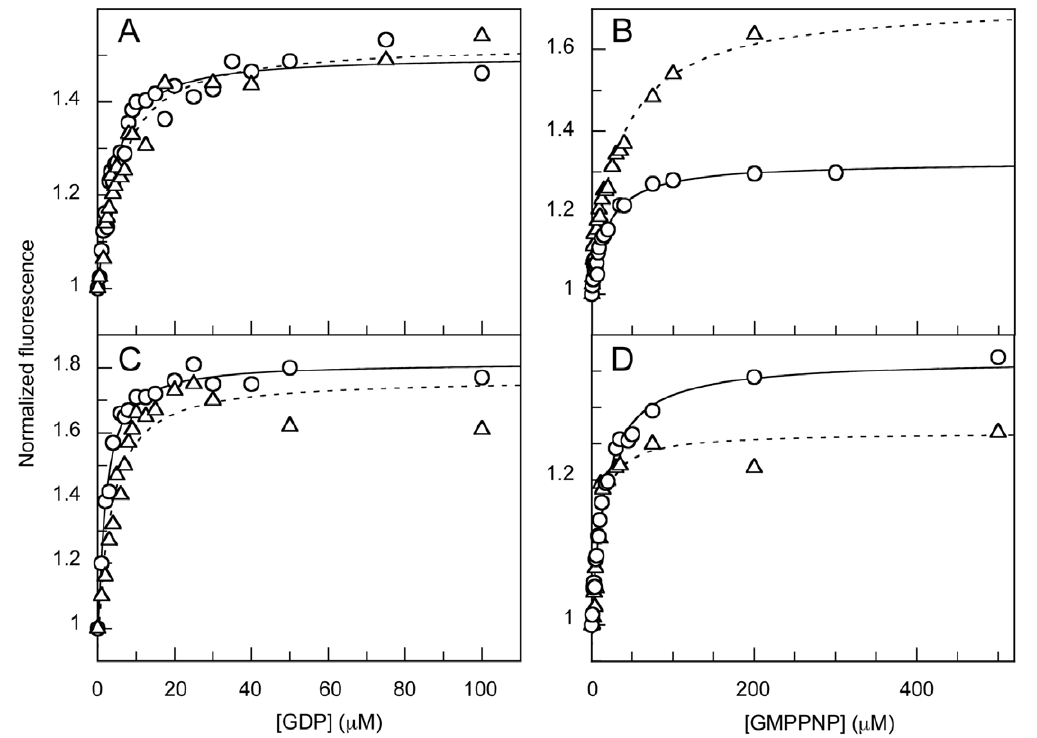
Figure 4. Binding of GDP and GMPPNP to GD1 and GD2-KH. The binding of GDP ( A and C ) or GMPPNP ( B and D ) was monitored by the increase in tryptophan fluorescence of GD1 ( A and B ) and GD2-KH ( C and D ) in the presence of 300 mM KCl (white triangles, dashed lines for the fitted curves) or 300 mM NaCl (white circles, plain lines for the fitted curves).